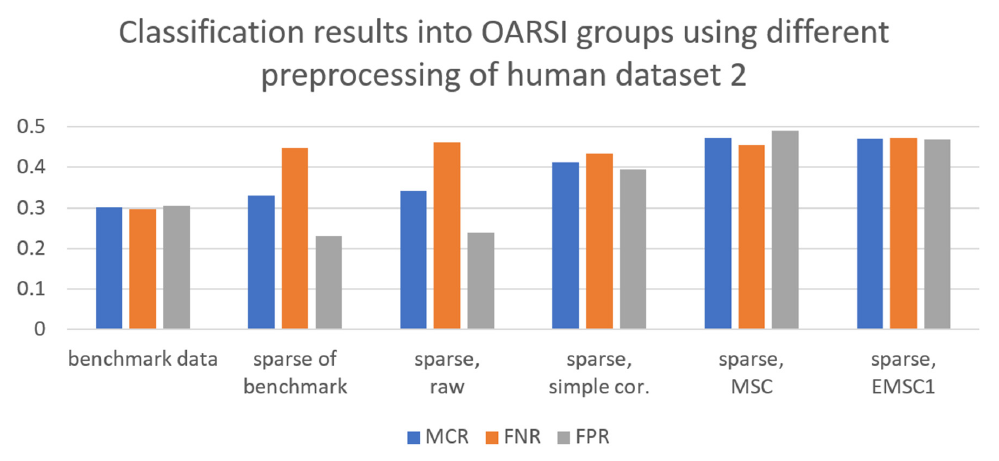
Figure 3. Binary PLSDA classification of healthy and damaged samples based on OARSI grades. Models were established using preprocessed spectra of human dataset 2. From left to right: (1) benchmark broadband data, (2) sparse spectra of the benchmark data, (3) sparse raw data, (4) sparse data with simple preprocessing, (5) sparse data preprocessed by MSC, (6) sparse data preprocessed by EMSC1. Overall misclassification rate (MCR = 1-Accuracy) as well as False Negative